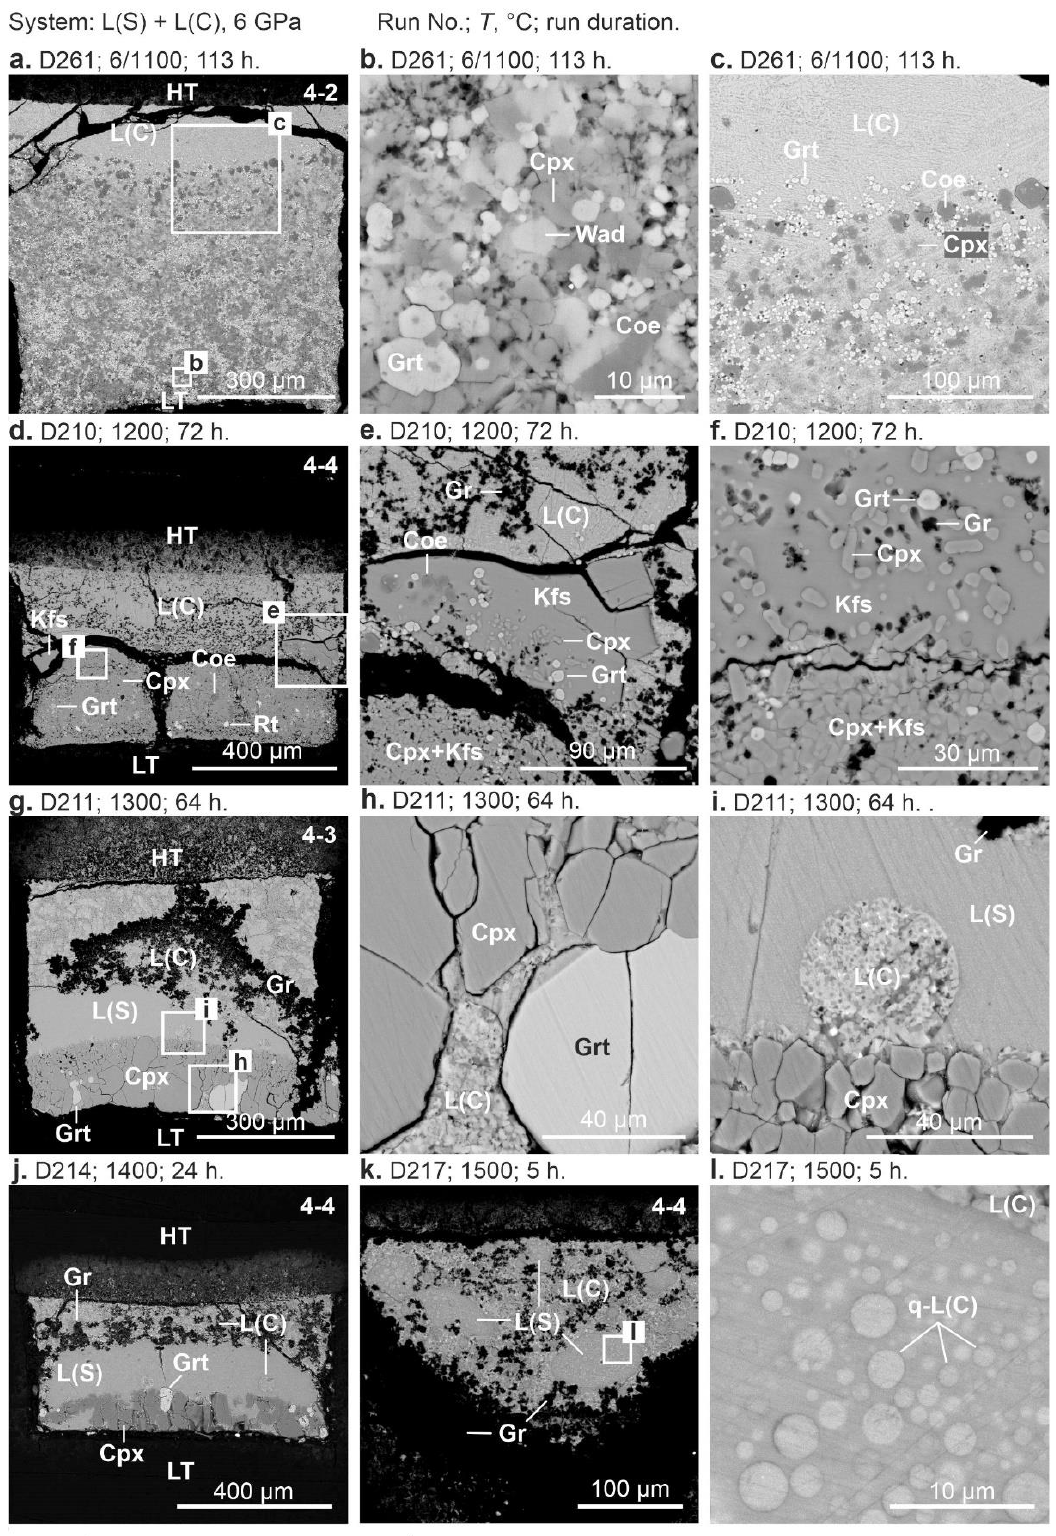
Figure 4. BSE of sample cross-sections in the system L(S)+L(C) at 6 GPa: ( a – c ) 1100 °C (run D261, 113 h); ( d – f ) 1200 °C (run D210, 72 h); ( g – i ) 1300 °C (run D211, 64 h); ( j ) 1400 °C (D214, 24 h); ( k , l ) 1500 °C (D217, 5 h). See the Figure 1 caption for other details.